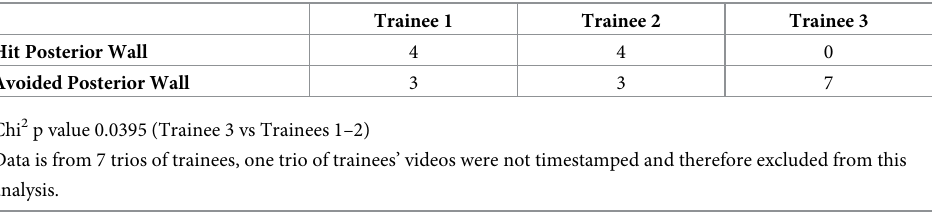
Table 3. Evidence for a bronchoscopic training effect from live viewing of colleagues’ sharp instrument errors.